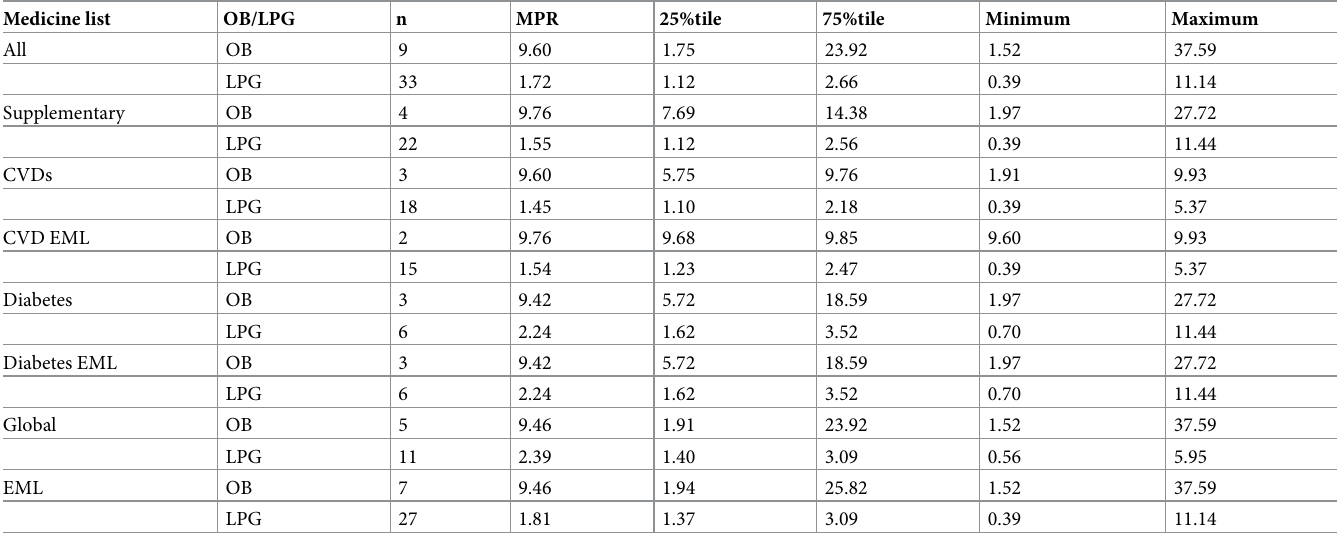
Table 2. Procurement prices for originator brands and lowest priced generics